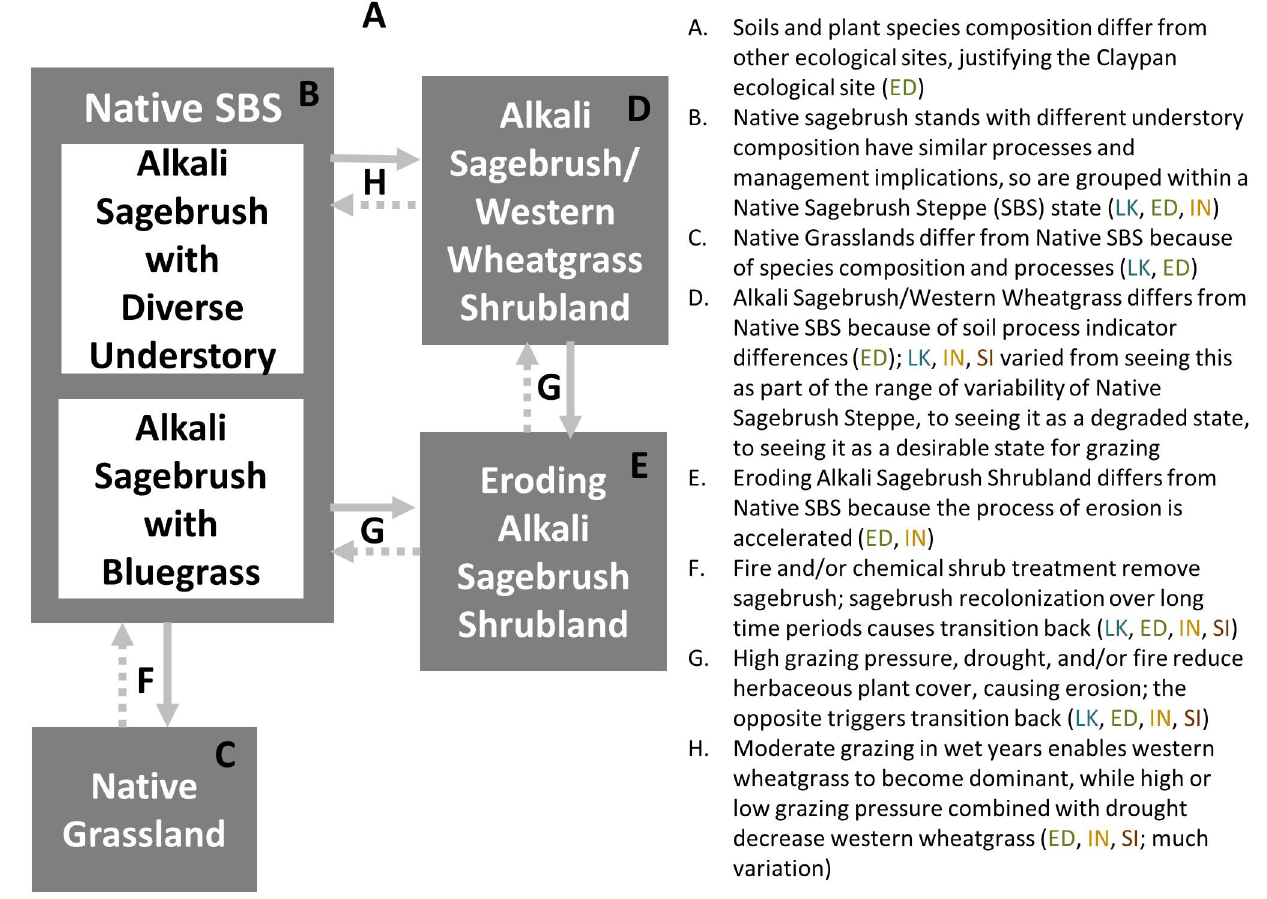
Fig. 2 . Simplified state and transition model of rangeland ecosystem dynamics for the Claypan ecological site, northwest Colorado, USA. Supporting information for model elements came from different parts of the model development process, which are indicated in parentheses. ED = Ecological data; LK = Local knowledge; IN = Integrated; SI =